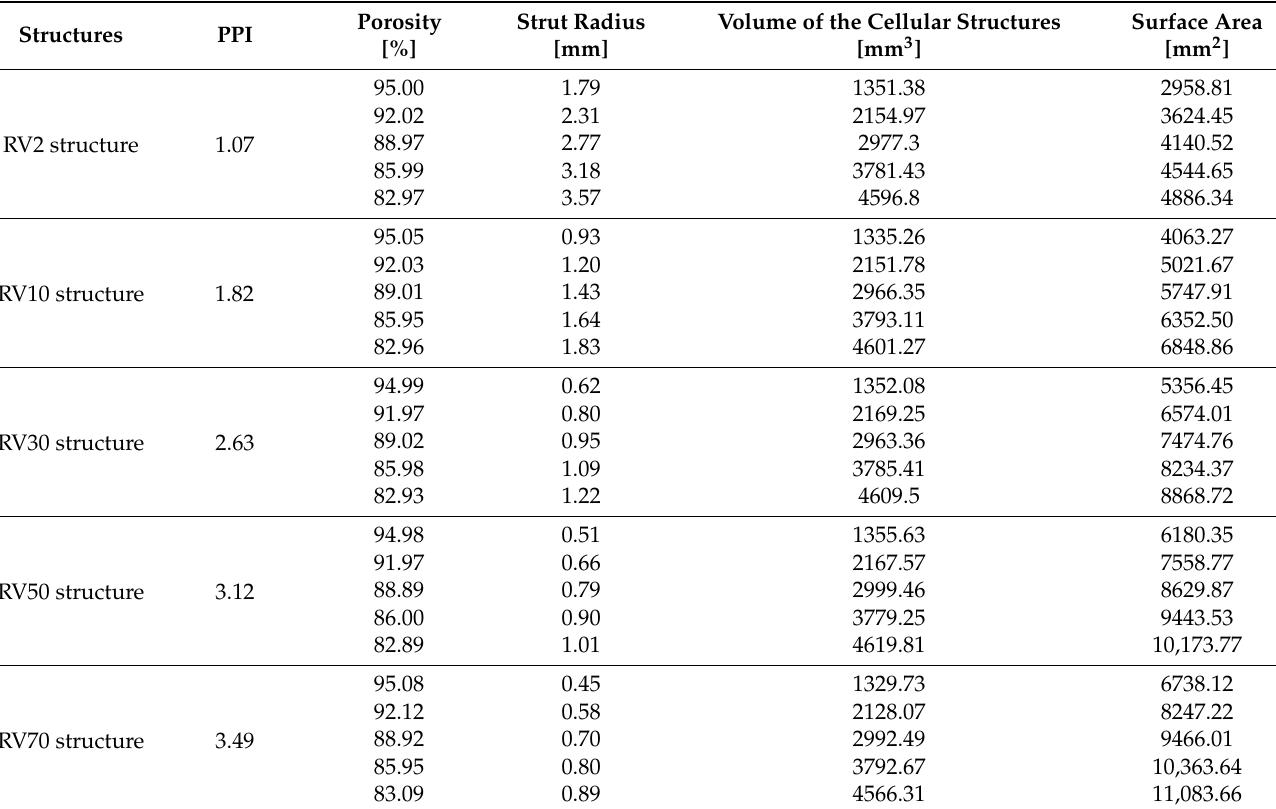
Figure 3. Strut-based cellular structures: ( a ) random Voronoi cellular structure with 2 seed points (RV2); ( b ) random Voronoi cellular structure with 10 seed points (RV10); ( c ) random Voronoi cellular structure with 30 seed points (RV30); ( d ) random Voronoi cellular structure with 50 seed points (RV50); ( e ) random Voronoi cellular structure with 70 seed points (RV70); ( f ) Kelvin structure with tetragon as base (KT); ( g ) Kelvin structure with hexagon as base (KH). Table 1. Specific geometrical parameters of the CAD